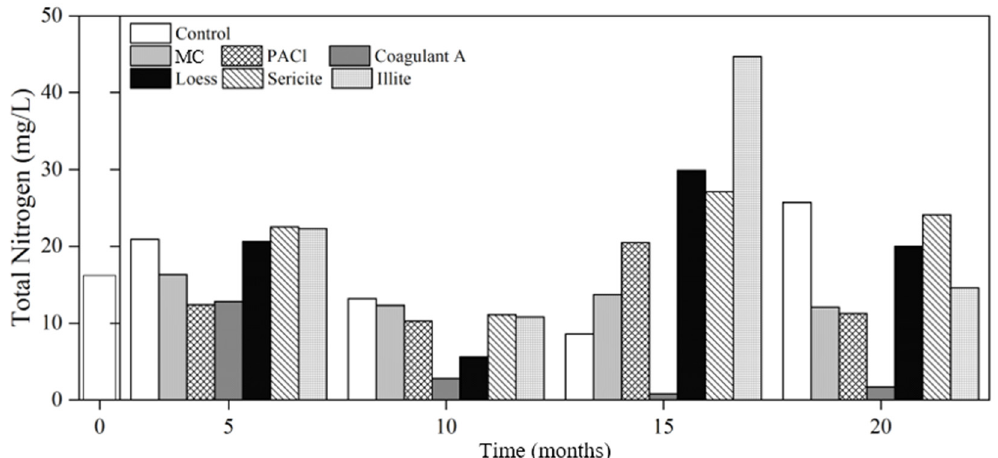
Figure 1. Changes in total nitrogen concentration in the control and treatments with various coagu- lants and minerals. MC: mineralized coagulant; PACl: polyaluminum chloride; A: commercial co- agulant.